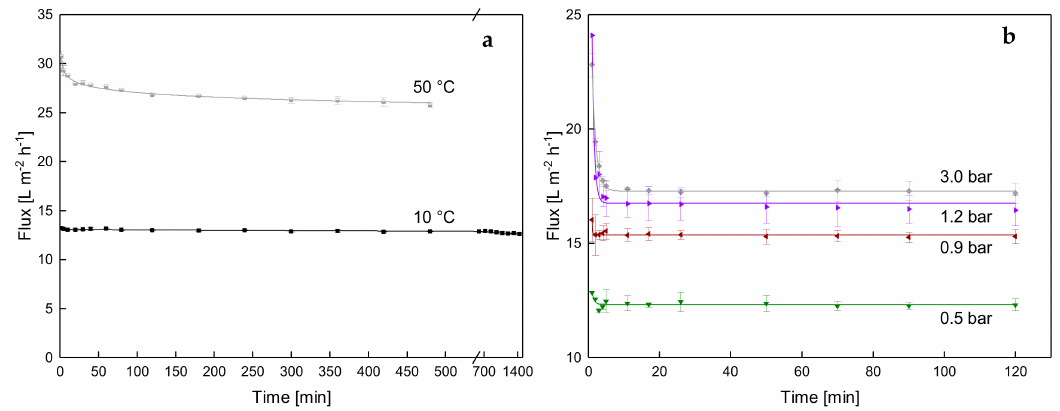
Figure 2. Flux as a function of time at di ff erent temperatures at the ∆ p TM of 0.5 bar ( a ) and at di ff erent ◦ C ( b ∆ p TM values at 10